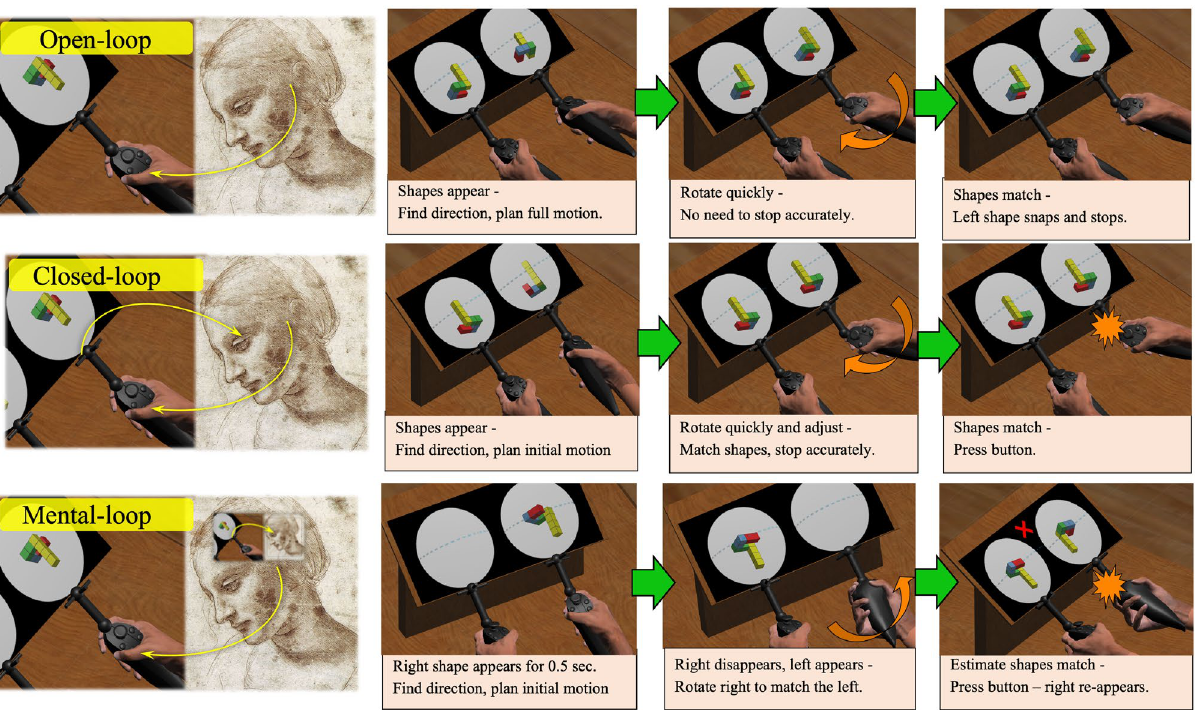
Figure 3. Trial structure in each of the motor-blocks: open-loop (top), closed-loop (middle) and mental-loop (bottom).